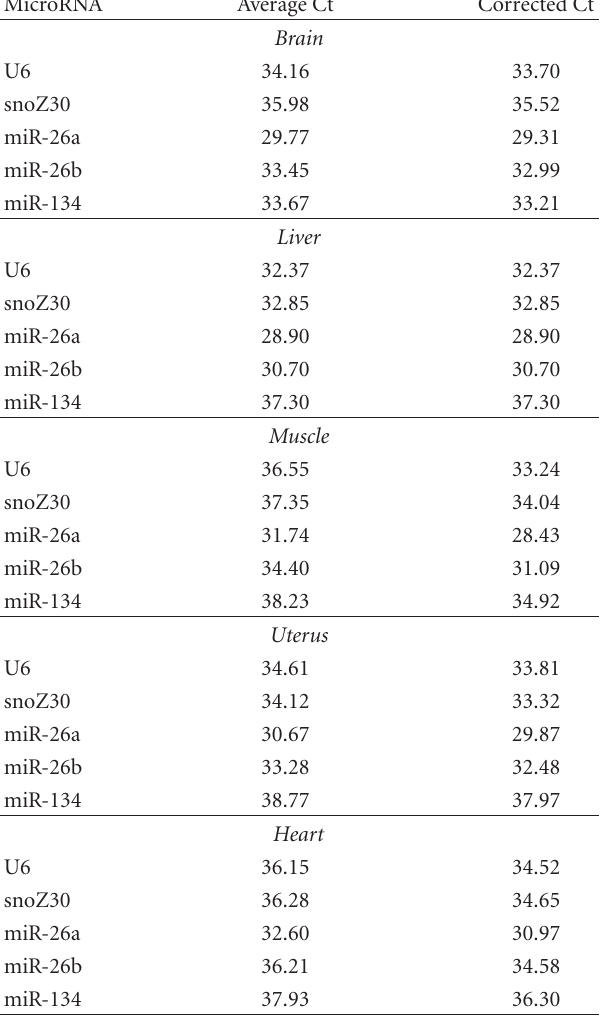
Table 3: List of miRNAs expressed in di ff erent tissues with their average Ct values. Corrected Ct values represent the correction made after the precise quantification of miRNA species with the lab- on-a-chip technology.